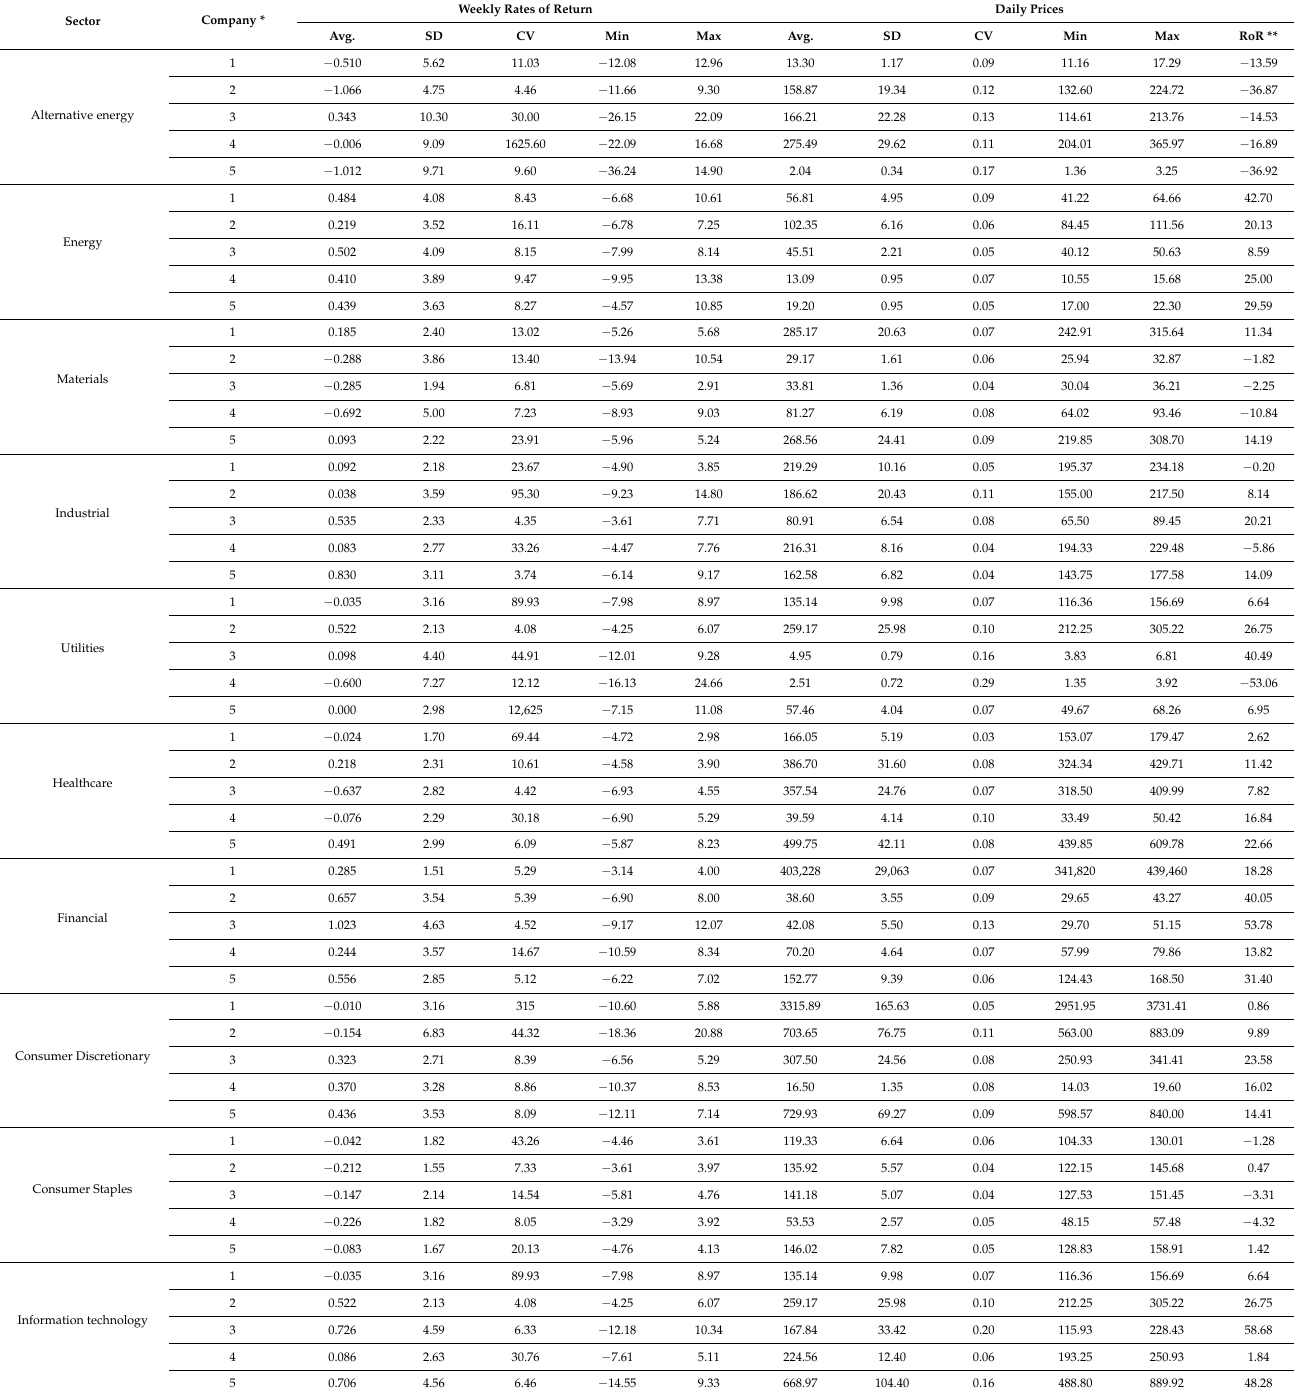
Table A3. Descriptive statistics for average weekly rates of return and daily prices: based on top five companies from stock market sectors. January–September